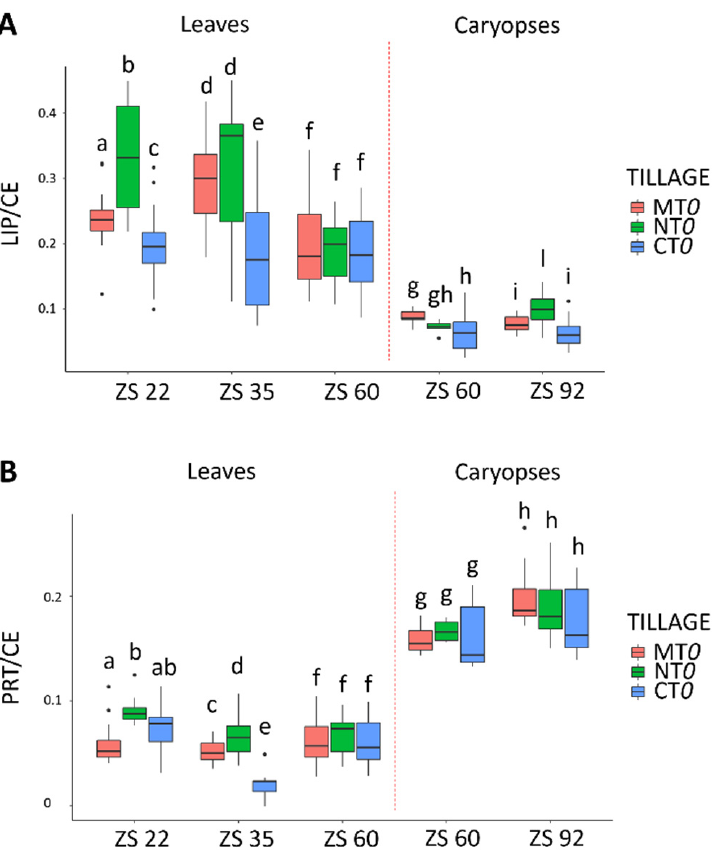
Figure 5. Statistical analysis of the biochemical composition of durum wheat leaves and caryopses collected at different sampling timepoints as a consequence of various soil management methods. The box plot shows the differences in lipid alkyl chains (LIP) ( A ) and protein (PRT) ( B ) content with respect to cellulose (CE). Tillage methods without fertilization processes are indicated with CT 0 (conventional Tillage), MT 0 (minimum Tillage) and NT 0 (no Tillage). Sampling times were ZS 22, ZS 35 and ZS 60 for leaves, and ZS 60 and ZS 92 for caryopses. The center line marks the median; edges indicate the 25th and 75th percentiles; vertical lines indicate the 5th and 95th percentiles; black points indicate the potential outliers. Different letters above box charts indicate a statistically significant difference among groups. Statistical significance was set at p < 0.05.